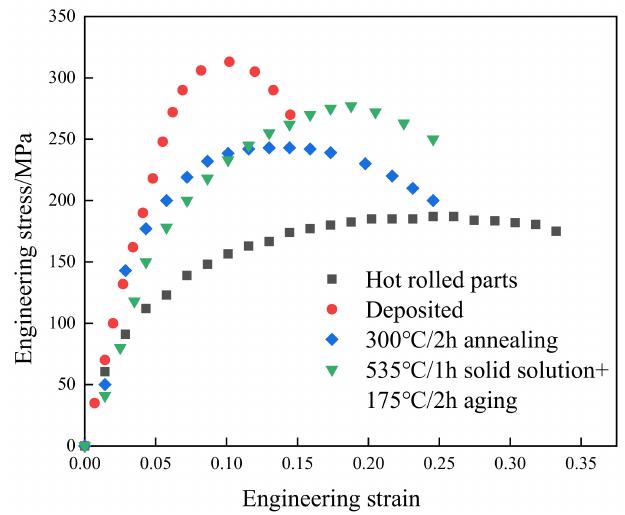
Figure 9. EDS results of solution aging sample.